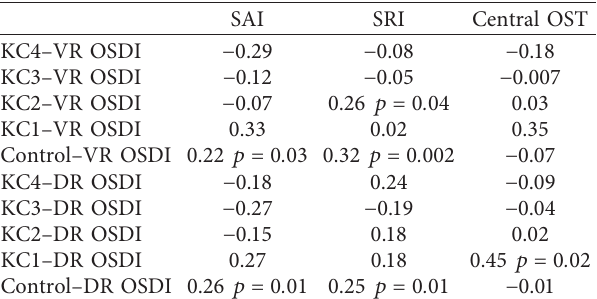
Data are given as mean ± SD. VR, vision-related; DR, discomfort-related. Table 4: Spearman correlation of vision- and discomfort-related Ocular Surface Disease Index (OSDI) subscores with surface characteristics at the corneal centre in different stages of kerato- conus (KC) and